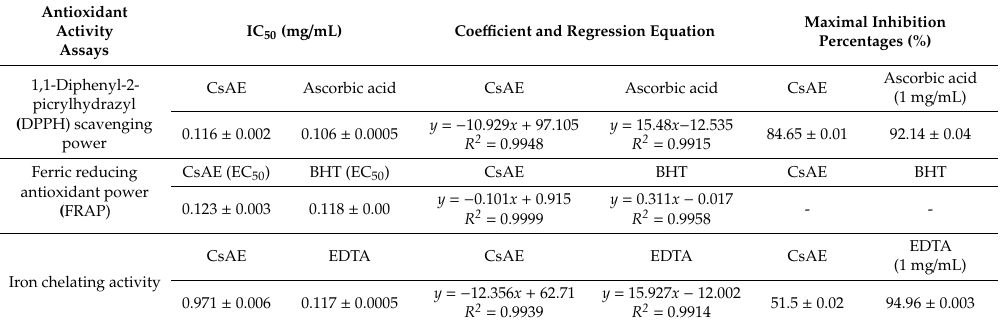
Table 2. Antioxidant activities of the C. siliqua aqueous extract and standards. Antioxidant